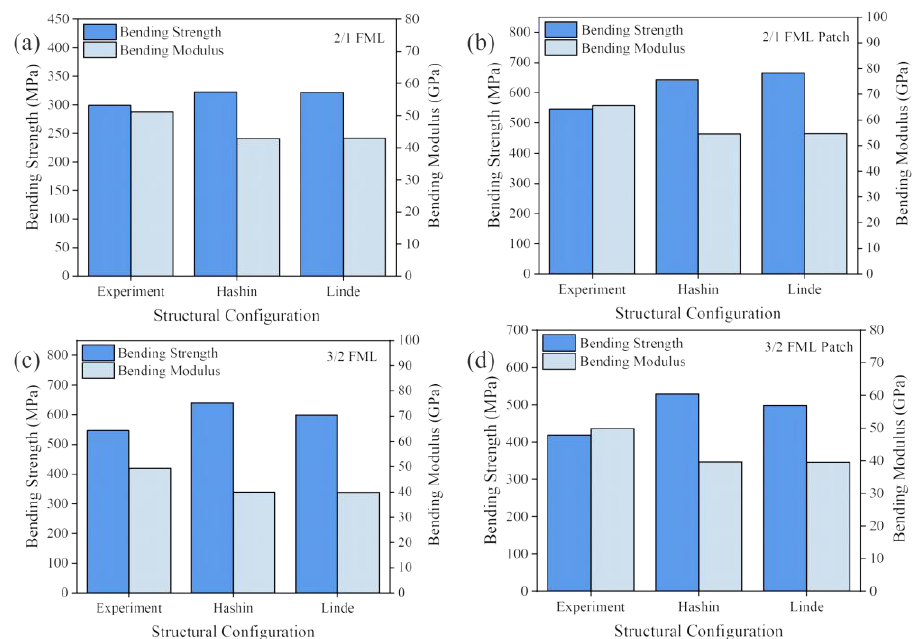
Figure 6. Bending modulus and strength of FMLs with different stack structures